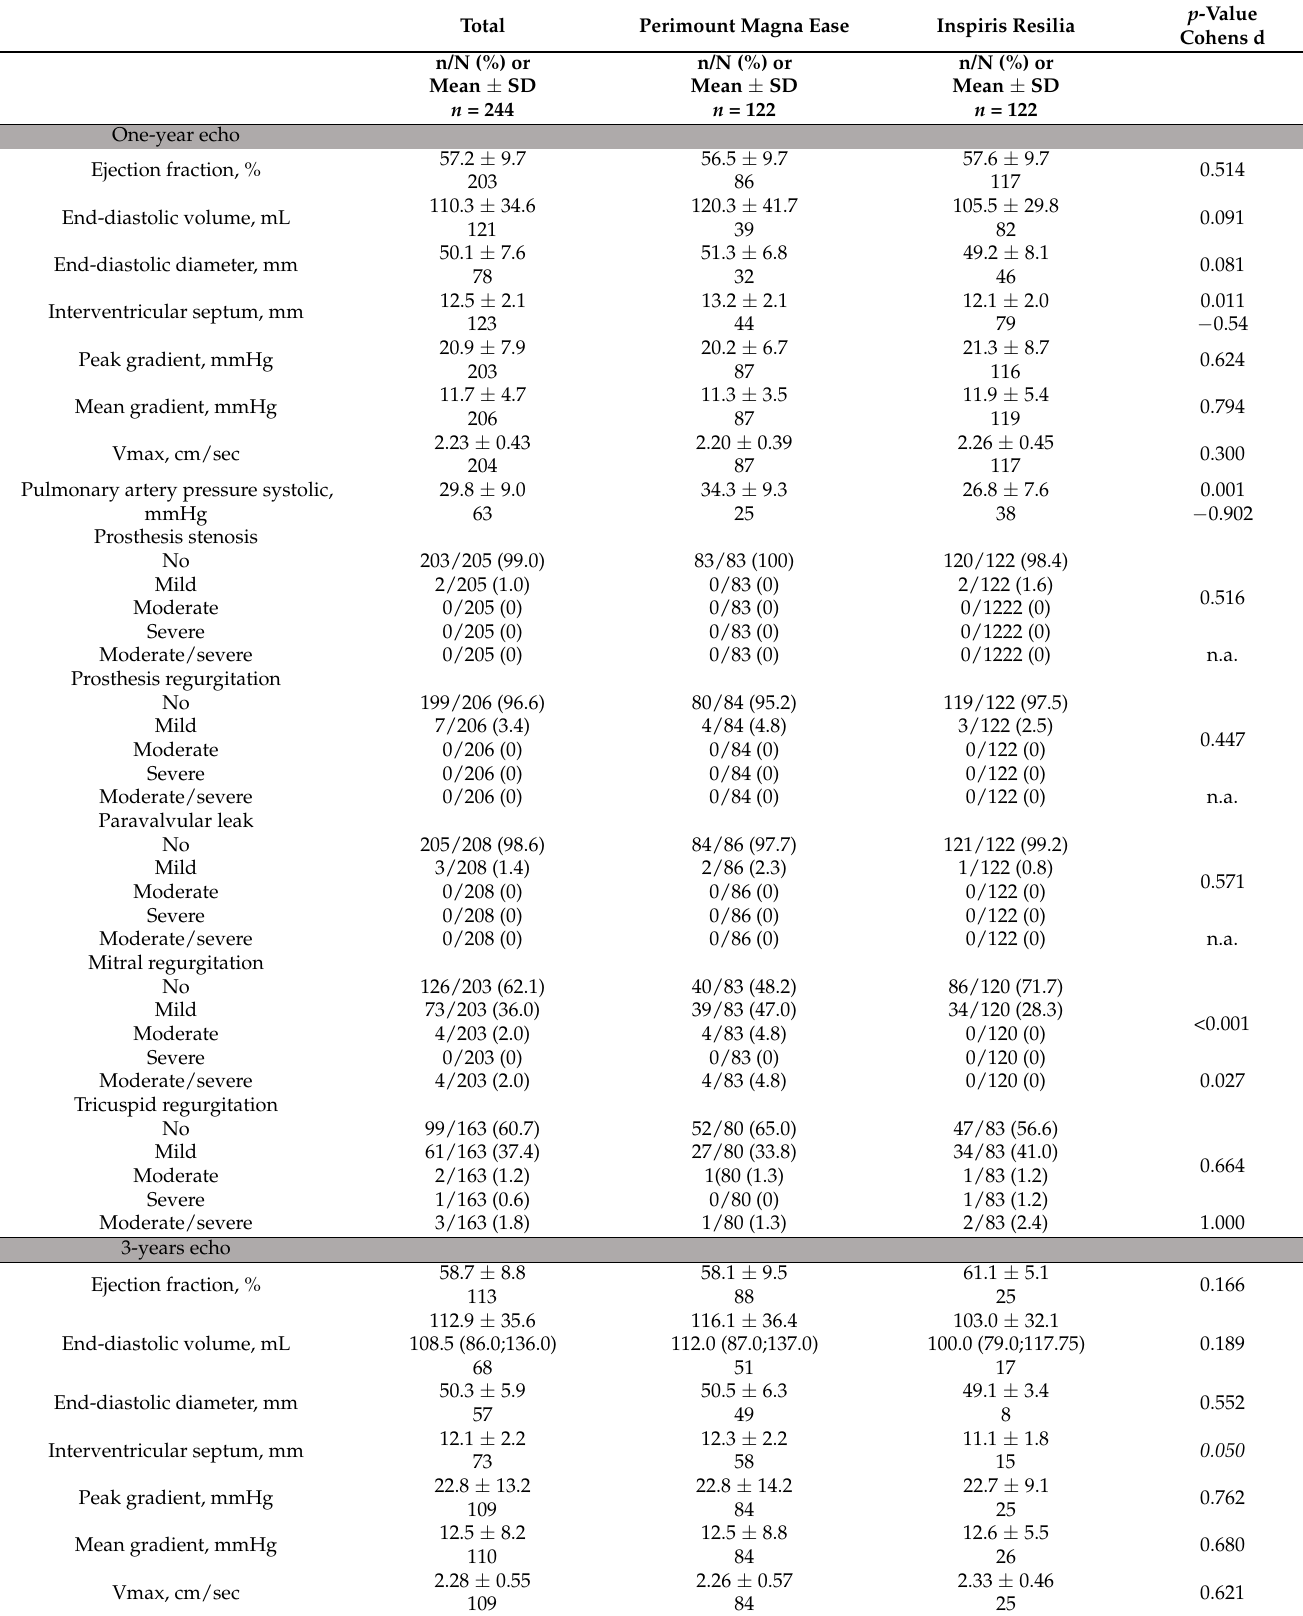
Table 2. PS matched cohort: one-year and 3-year echocardiographic